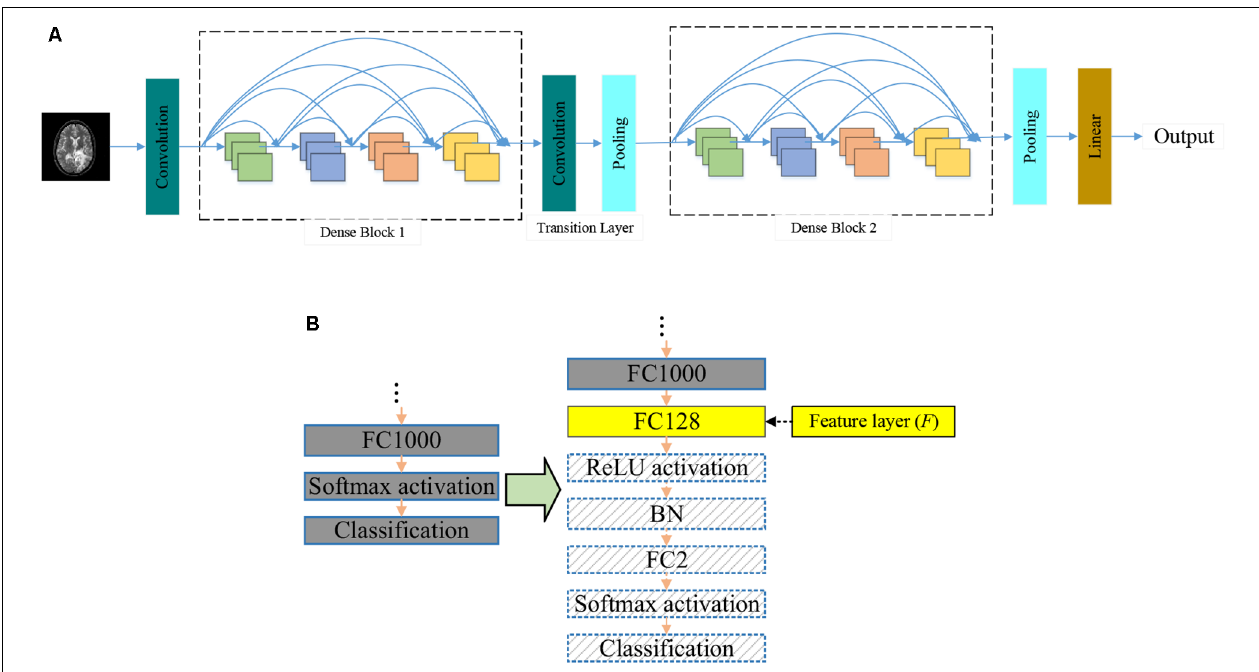
FIGURE 3 | Backbone of the proposed DSNN. (A) The general view of DenseNet. (B) The modifications in the pre-trained DenseNet.